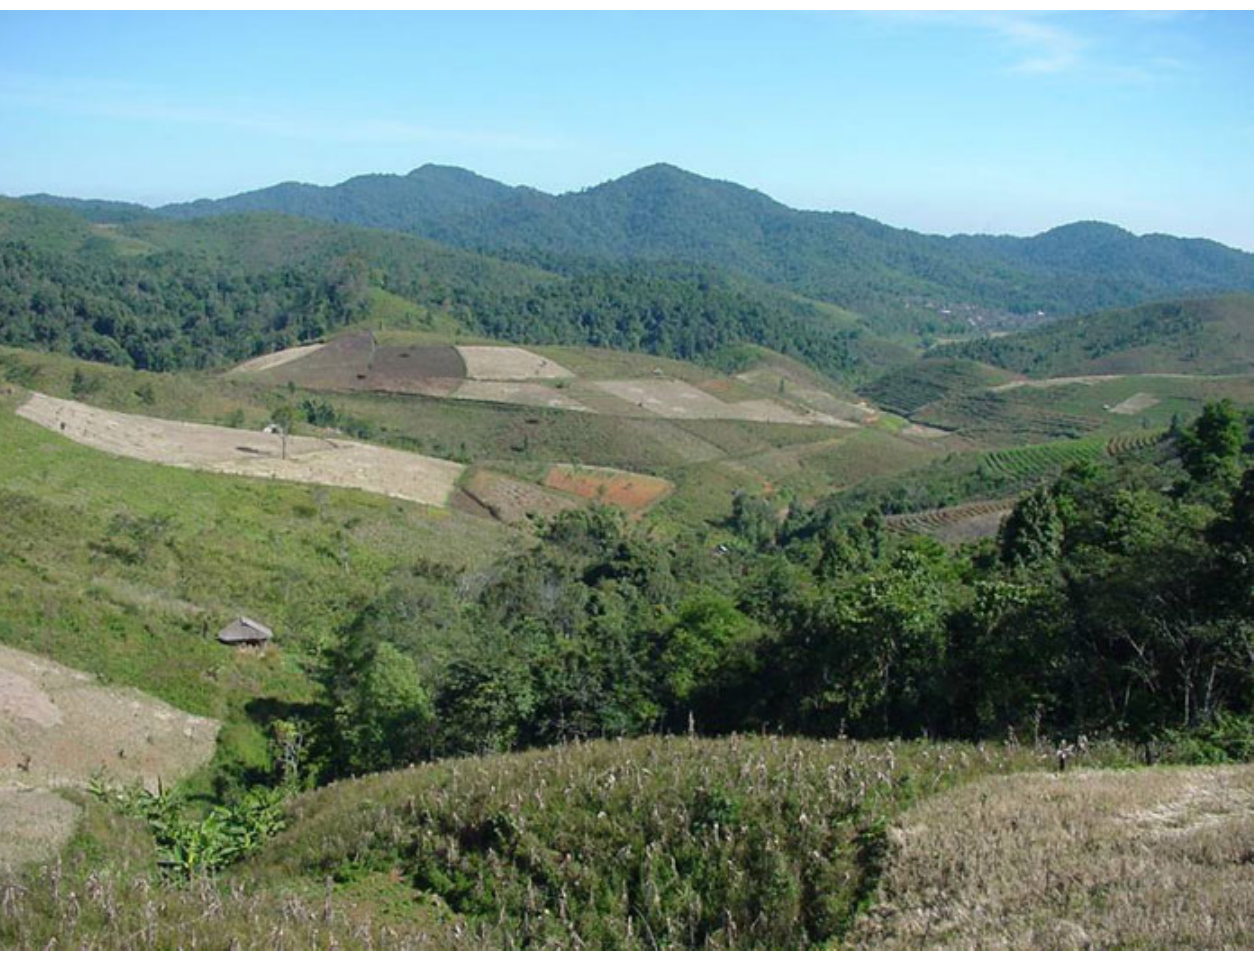
Figure 2. A typical landscape in the Mengsong region of Yunnan Province, southwest